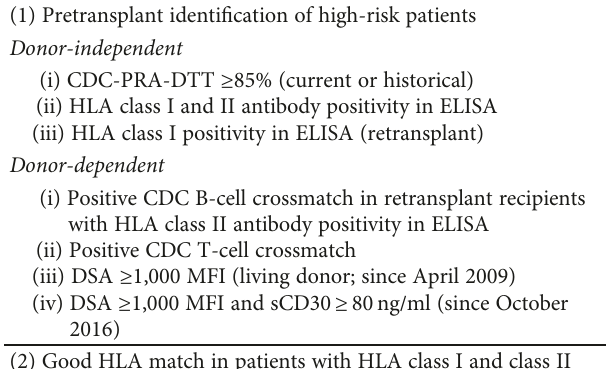
Table 1: “ Heidelberg Algorithm ” (applied since April